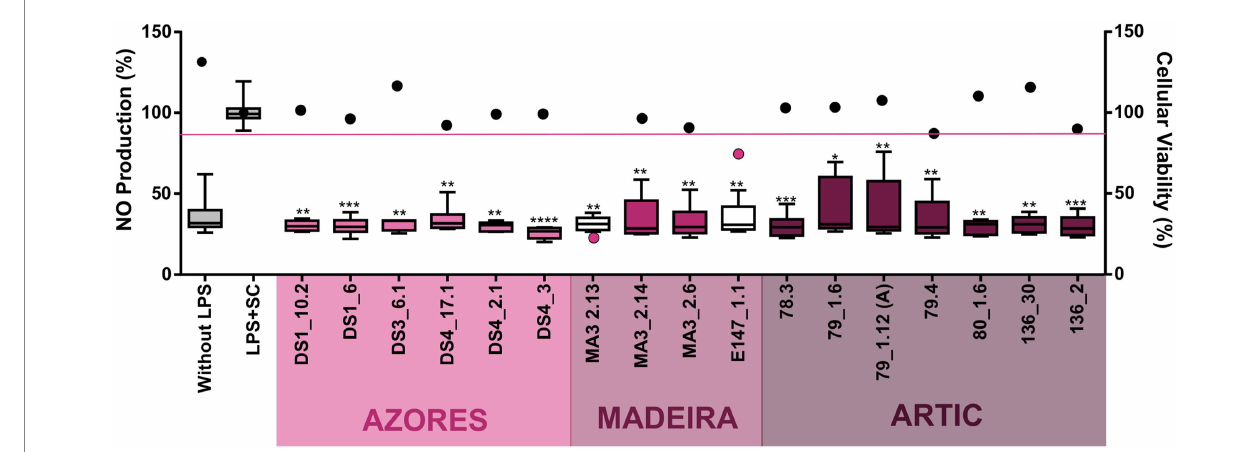
FIGURE 5 Anti-inflammatory activity of the deep-sea actinobacterial crude extracts (15 μ g/ml) after inflammation induced by LPS exposure (200 μ g/ml). The inflammatory effect on the RAW 264.4 cell line as measured by NO production (box-whisker graph) and the effect on the viability of the same cellular line (plot graph) are shown after 48 h of exposure. Only the extracts with statistically significant differences are indicated in the graphs. All plot values represented below the pink line indicate that the extracts significantly reduce cell line viability in addition to having anti-inflammatory activity. Without LPS and LPS + SC denote positive and solvent with lipopolysaccharide controls, respectively. Values are demonstrated as interval displaying the data distribution through their quartiles with 5–95% confidence from two independent assays conducted in triplicate and line within the box-whisker represents the median. Significant differences compared to the solvent control are annotated with asterisks in the graphs (* p < 0.05; ** p < 0.01; *** p < 0.001; **** p < 0.0001).